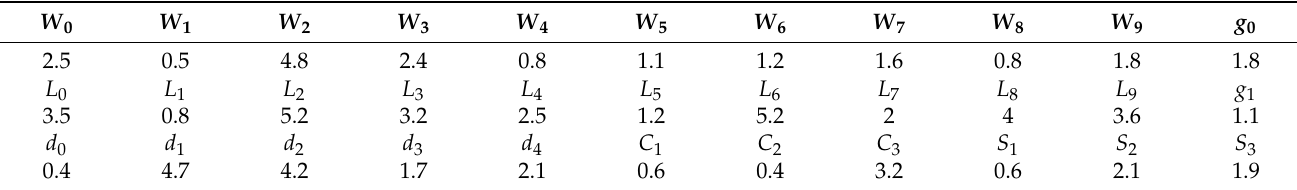
Table 1. Optimal parameters of the proposed filter. (Unit: